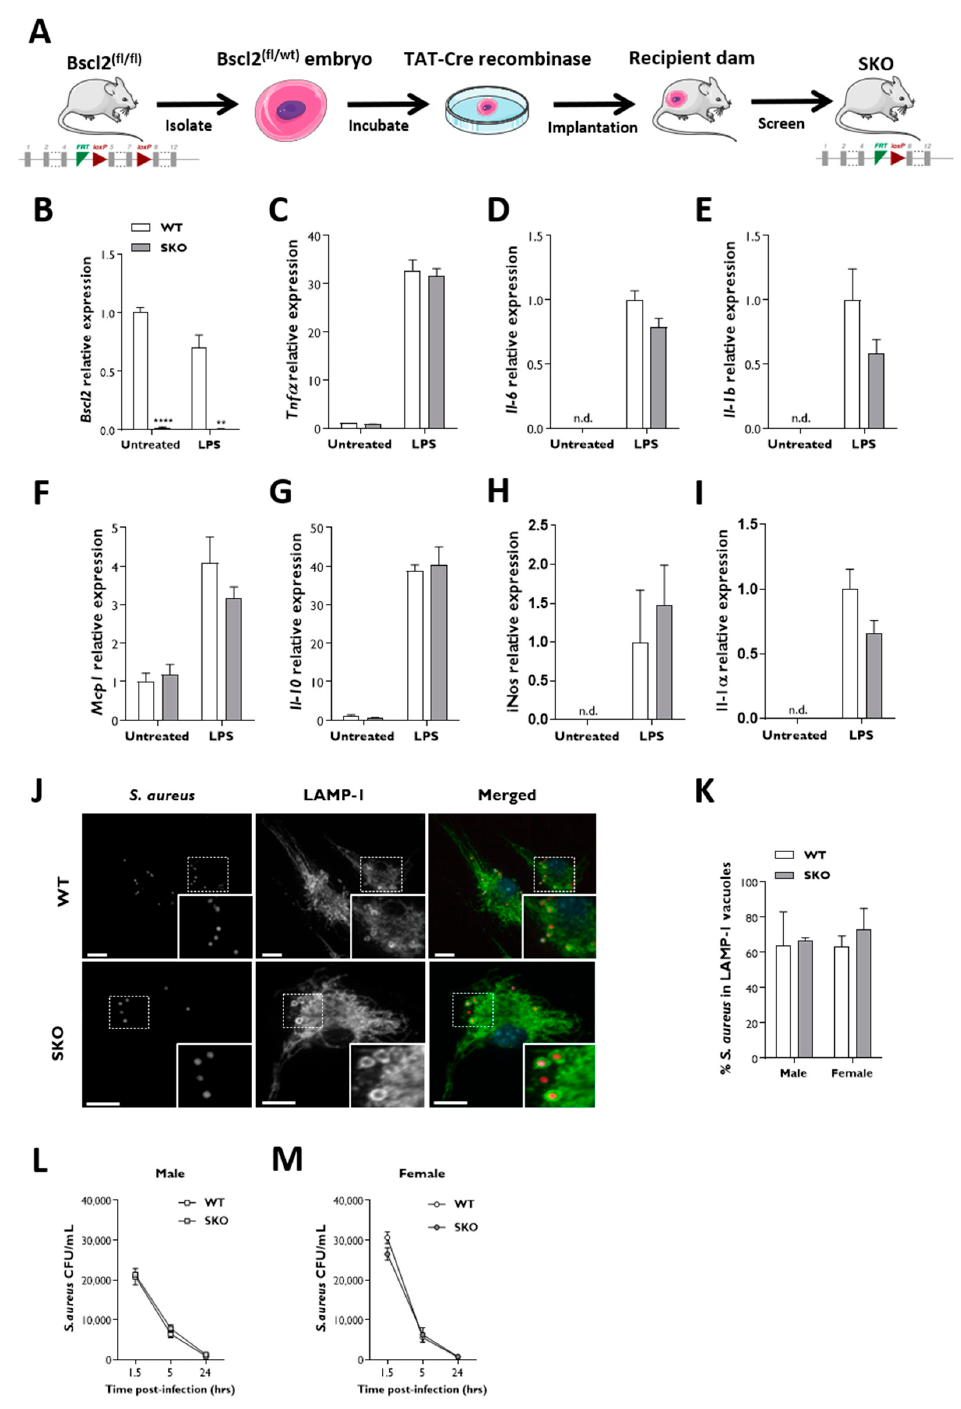
Figure 3. Bscl2 knockout (SKO) mice BMDM efficiently respond to lipopolysaccharides and Staphylococcus aureus challenge. ( A ) Strategy for the generation of SKO global knockout mice. qPCR was performed to evaluate the expression levels of ( B ) Bscl2 and ( C – I ) a panel of cytokines in female SKO BMDM challenged with LPS ( n = 3). The gene expression was normalized to three reference genes ( NoNo , Ywhaz and Hprt ). Data are represented as mean ± SEM, ** p < 0.01, **** p < 0.0001, n.d., not detectable. ( J ) Representative confocal micrographs of the LAMP-1 distribution in BMDM infected with S. aureus - mCherry ( n = 6). Dotted boxes indicate selected regions magnified in the white boxes. Bars denote 14 µ m. ( K ) Quantification of the LAMP-1 association with S. aureus -mCherry. Data are represented as mean ± SEM. ( L , M ) Colony-forming units (CFU) of S. aureus inside male and female